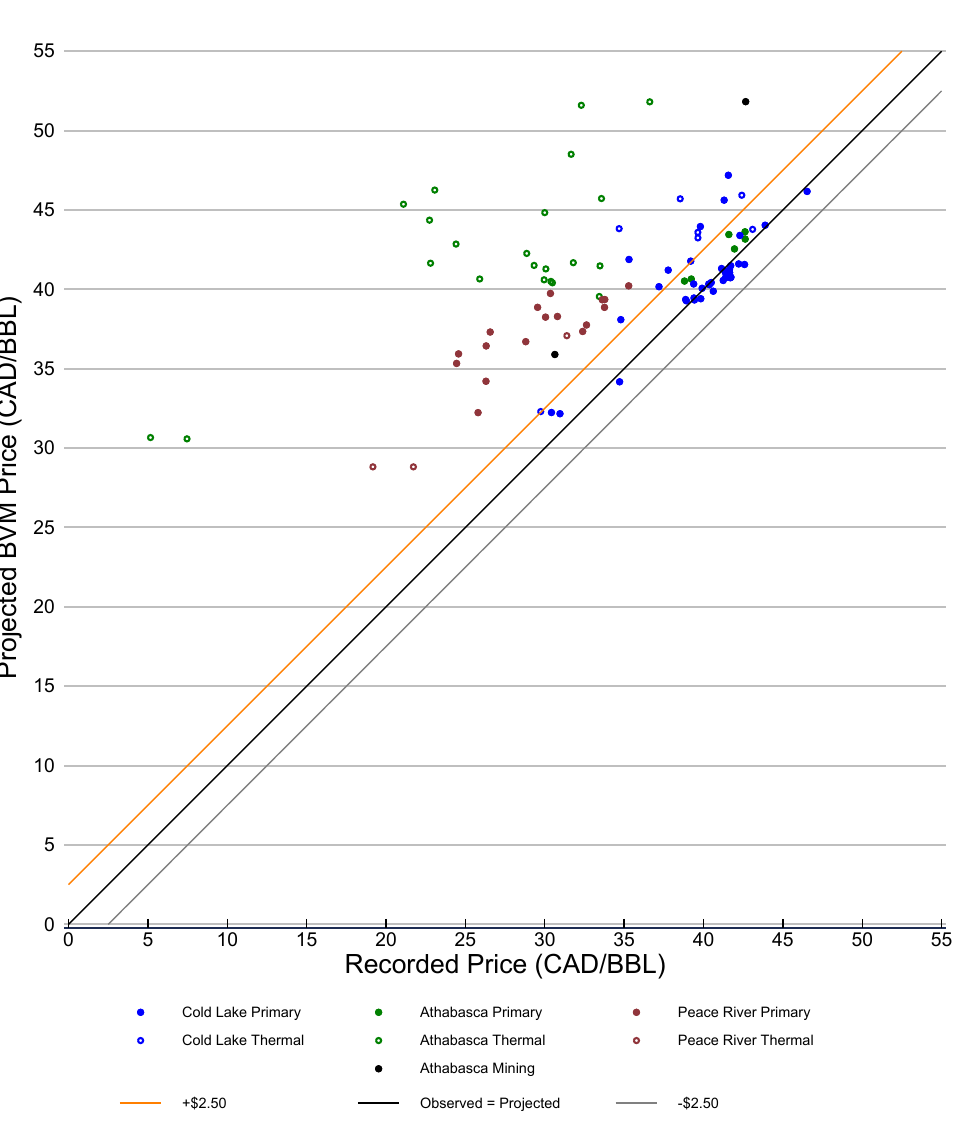
Figure 1. Counterfactual BVM valuation vs. observed valuation for oil sands projects (2016–2019 production-weighted averages). “Primary” is in situ production wherein heavy oil flows naturally into a well due to natural pressure and temperature; “thermal” is in situ production requiring steam injection into subsurface formations; and “mining” is surface mining of heavy